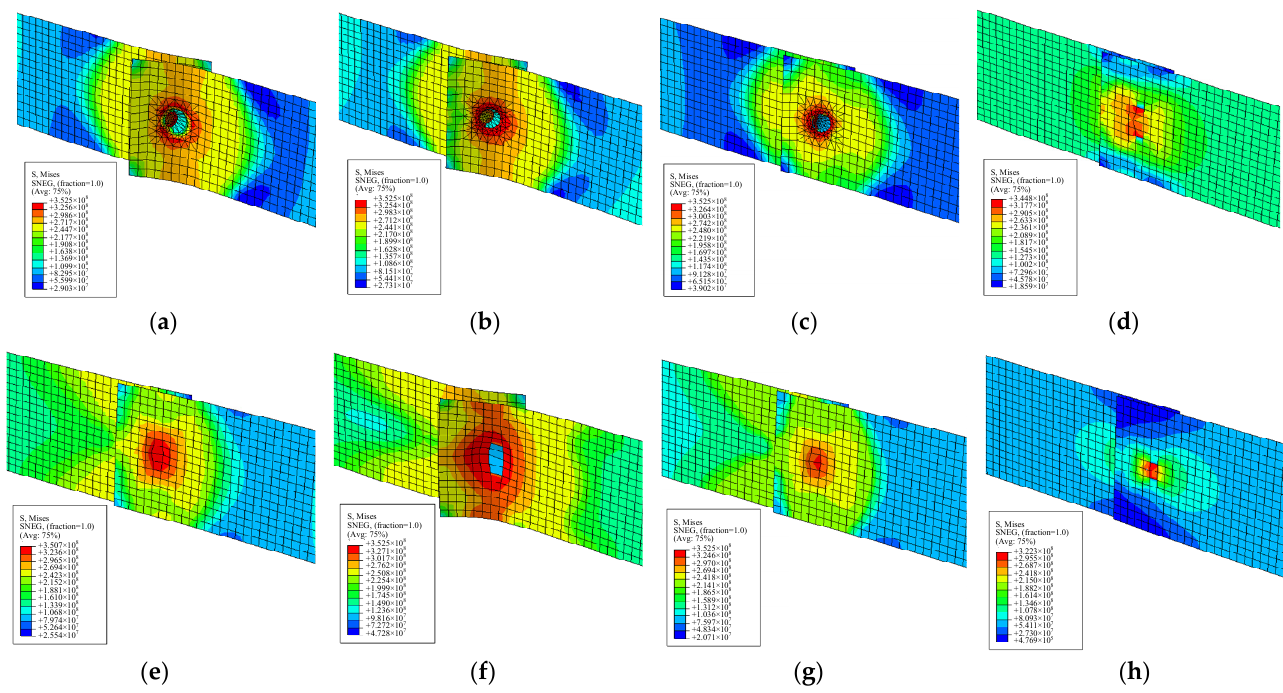
Figure 11. The Mises stress cloud diagrams and failure modes: ( a ) 1-1, ( b ) 1-2, ( c ) 1-3, ( d ) 2-1, ( e ) 2-2, ( f ) 2-3, ( g ) 3-1, ( h ) 3-2.